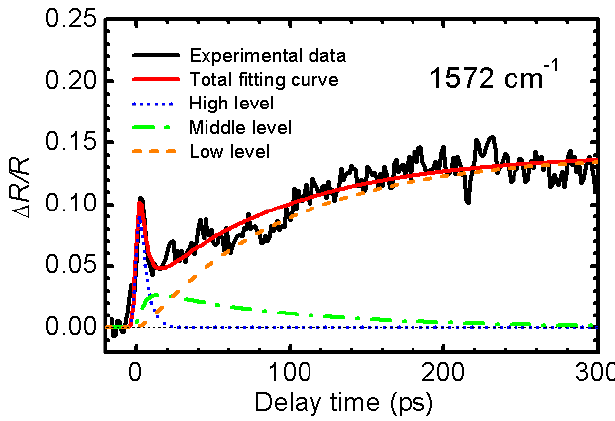
Figure 9. Temporal profiles of reflectivity change at 1572 cm −1 in (EDO-TTF) Colored curves represent fitting curves using three-level model (see Fukazawa et al . [16] for